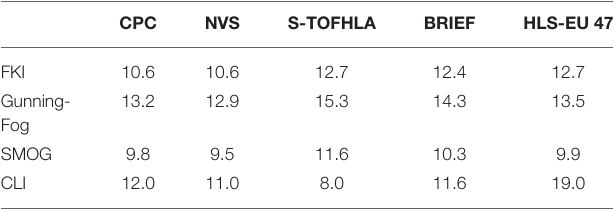
TABLE 4 | Comprehension in the subgroups by socio-demographic variables and subjective health.